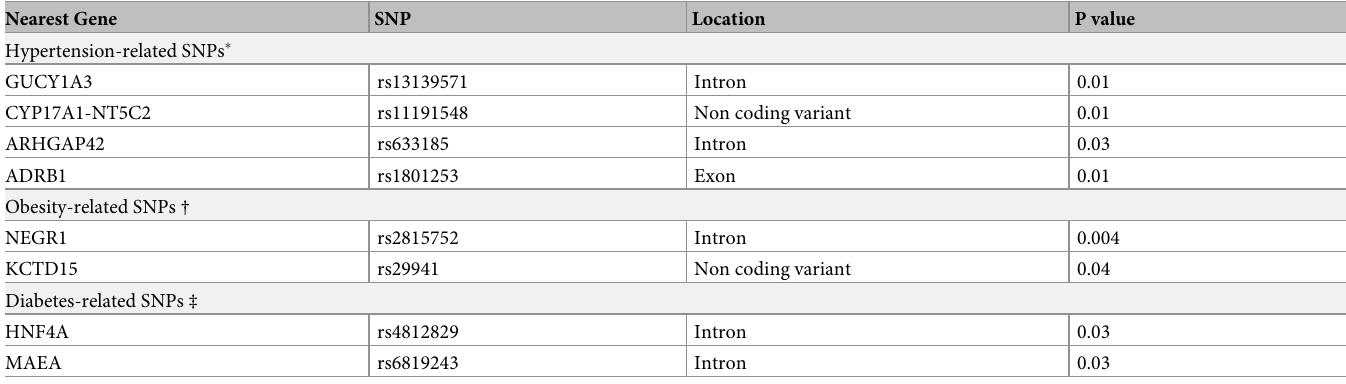
Table 2. Results of single SNP analysis: SNPs with suggested association (p < 0.05). Nearest